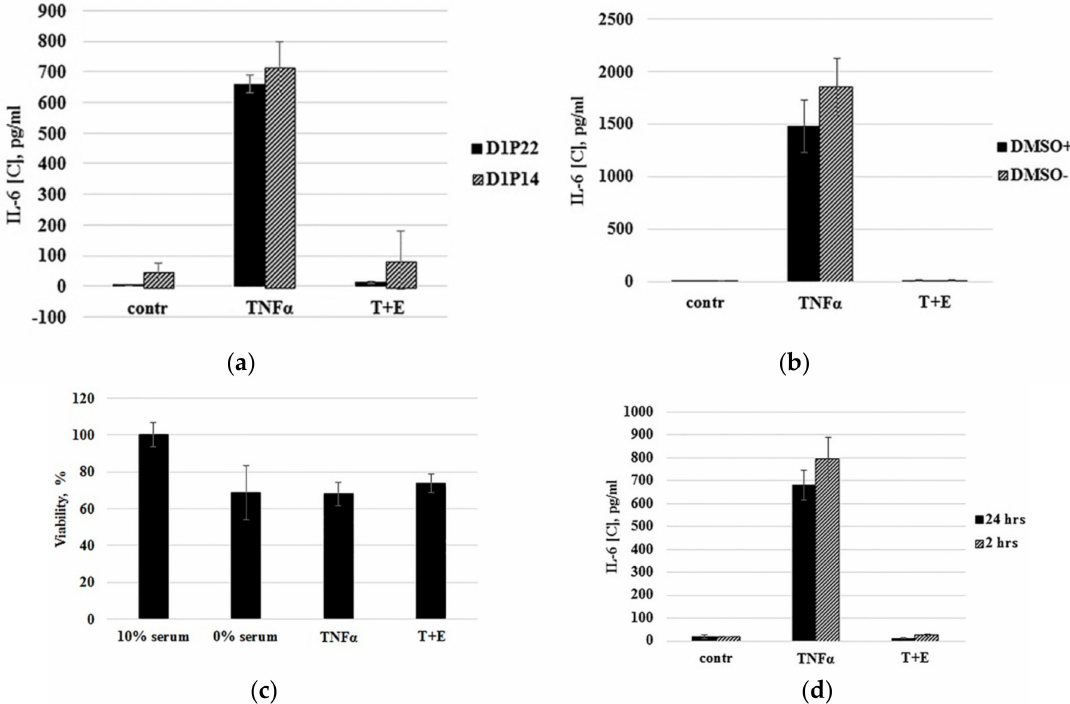
Figure 4. Optimization of ready-to-use cell bioassay. ( a ) Comparison of IL-6 expression by continuously subcultured in vitro (Passage 22) and cryopreserved (Passage 14) cartilaginous cells from the same donor. ( b ) TNF- α induced the response of ready-to-use cryopreserved cells due to di ff erent thawing conditions. Thawed cells were directly seeded to the wells (DMSO + ) or washed out of DMSO by centrifugation before seeding (DMSO-). ( c ) MTT viability test. Cells were incubated in media with serum (10% serum) and no serum (0% serum) for 24 h. Serum-deprived cells were treated with TNF-